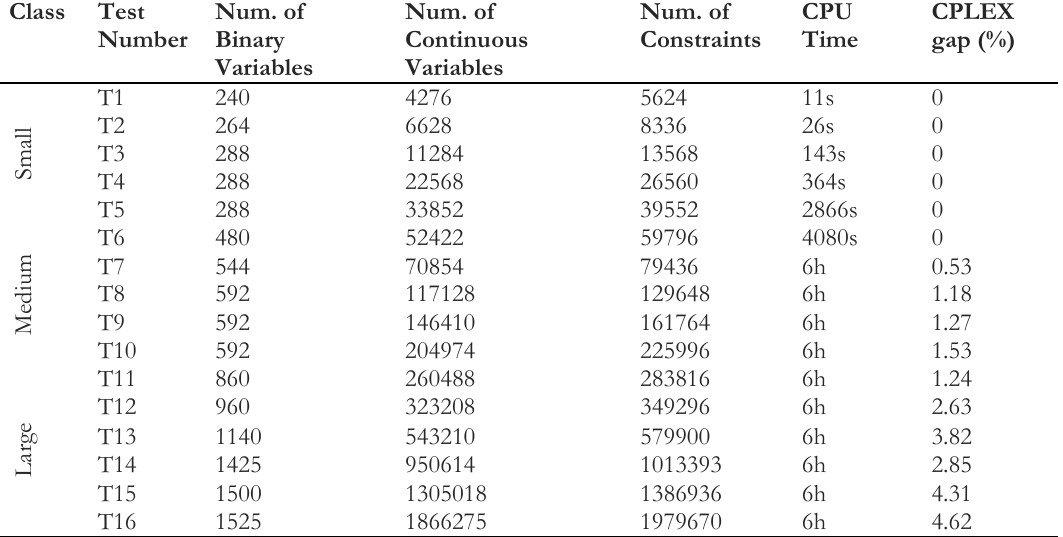
Table 11. Results from solving the model using CPLEX